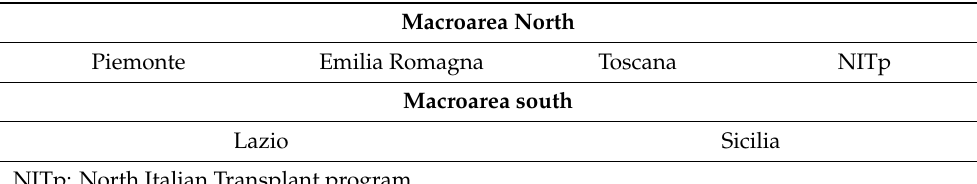
Table 1. Strip continuous model as described in the “national protocol for the management of surplus organs in all transplant programs” for exceeding management of the lungs. Rotation of the strip will scale both the region that has accepted the surplus organ and all those regions that have rejected